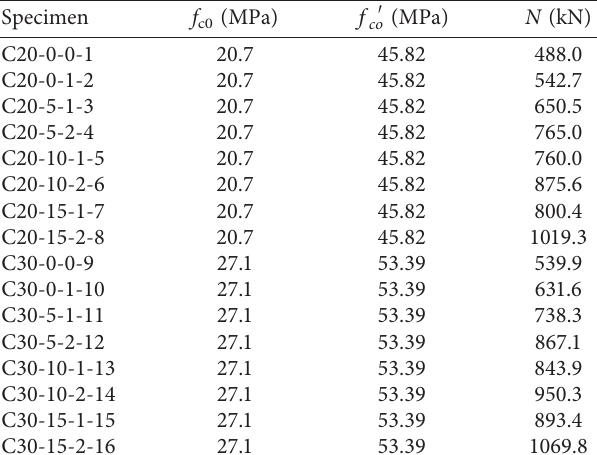
Figure 3: Loading apparatus and LVDTs. Table 3: Experimental results of